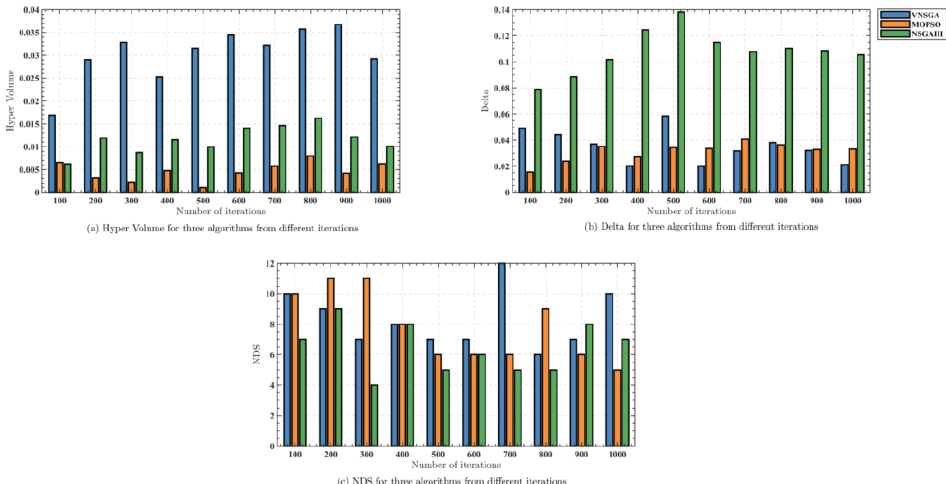
Figure 12. Hyper volume, Delta, and NDS for three algorithms from different iterations for 100 m R s max and 200 m R c max with respect to area A.